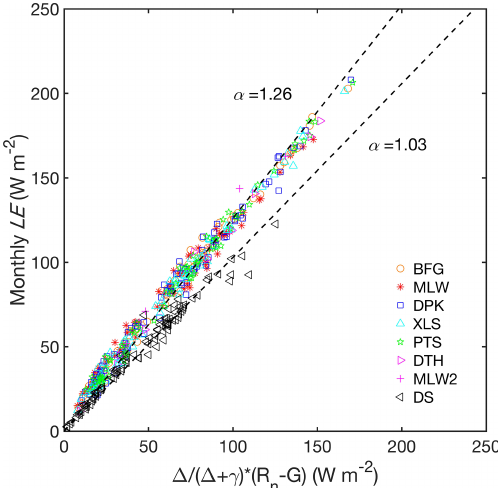
Figure 6. Comparison of observed monthly latent heat flux with Priestley–Taylor model prediction using the original α coefficient of 1.26 and a modified coefficient of 1.03. Here R n is net radiation, G is heat storage in the water column, (cid:49) is the slope of the saturation vapor pressure curve, and γ is the psychrometric